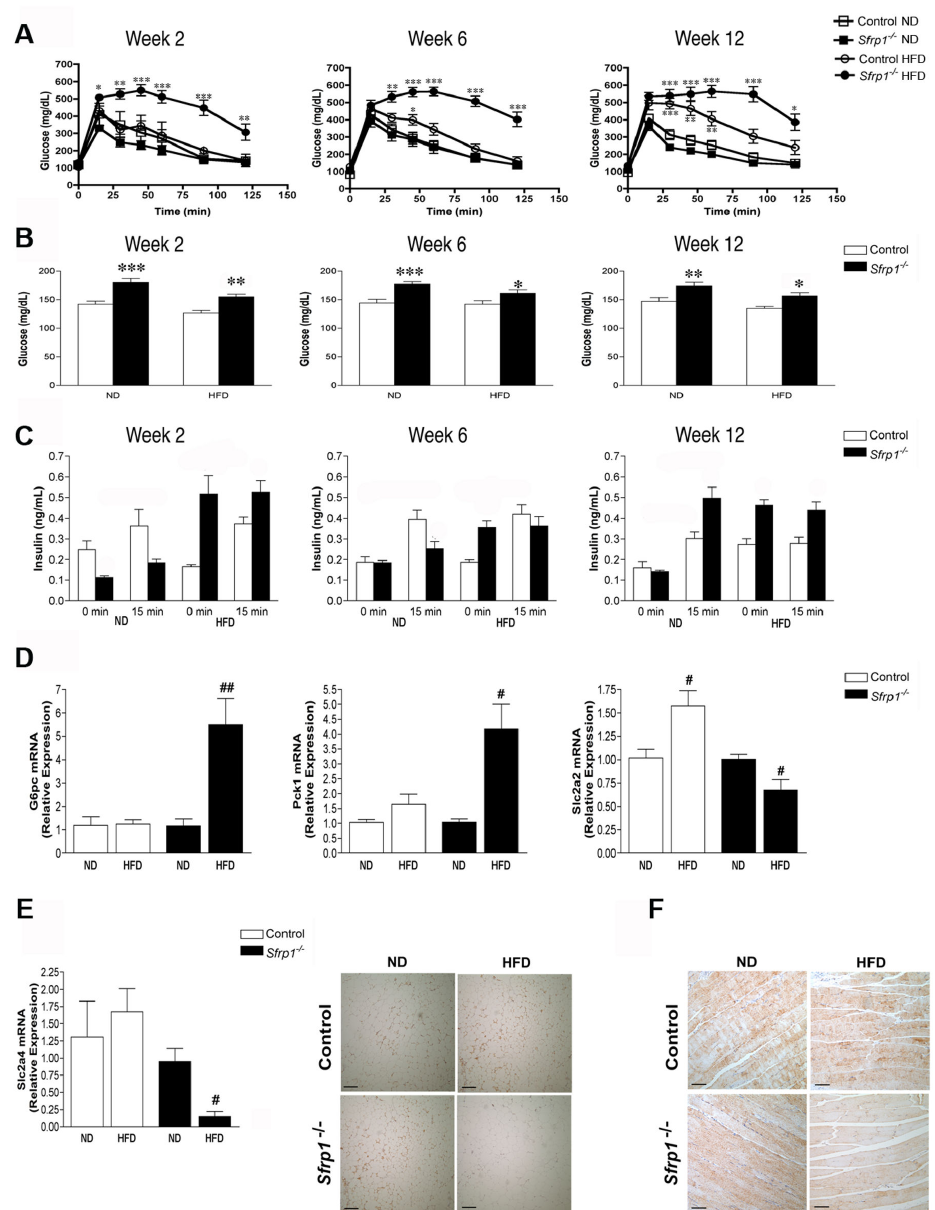
Figure 2. Aberrant glucose homeostasis and insulin secretion observed in Sfrp1 -/- mice. (A) Glucose tolerance test (GTT) was performed at three separate time points during the study (2 weeks, 6 weeks, and 12 weeks). After a 16-18 h fast, mice were injected with 2g/kg BW glucose and blood glucose levels were monitored for 2 h. (B) Blood glucose levels were measured prior to GTT initiation. (C) Plasma insulin levels were measured before (0 min) and after (15 min) glucose injection. (D) For real-time PCR analysis of G6pc , Pck 1, and Slca2 gene expression, total RNA was isolated from liver of mice in each treatment group (n=6). The results shown represent experiments performed in duplicate and normalized to the amplification of β-actin mRNA. Bars represent mean ± SEM of the relative expression with respect to ND fed mice. (E) Left panel , For real-time PCR analysis of Slca4 gene expression, total RNA was isolated from the gonadal fad pad from mice in each treatment group (n=6). Real-time PCR analysis was carried out as described above. Right panel , gonadal fat pad sections were subjected to immunohistochemical analysis and stained for Slc2a4 (brown chromogen).Representative images were captured at 100X and are displayed for mice in each treatment group (scale bar 200 μm). (F) Muscle sections were stained for Slc2a4 and 200X images were captured as described above (scale bar 100 μm). (*p<0.05,**p<0.01, ***p<0.001 significantly different from control mice fed a ND using Bonferroni’s t test after a two-way ANOVA; # p<0.05, ## p<0.01, ### p<0.001 significantly different from respective ND fed mice using student’s t test.) . doi: 10.1371/journal.pone.0078320.g002 PLOS ONE |